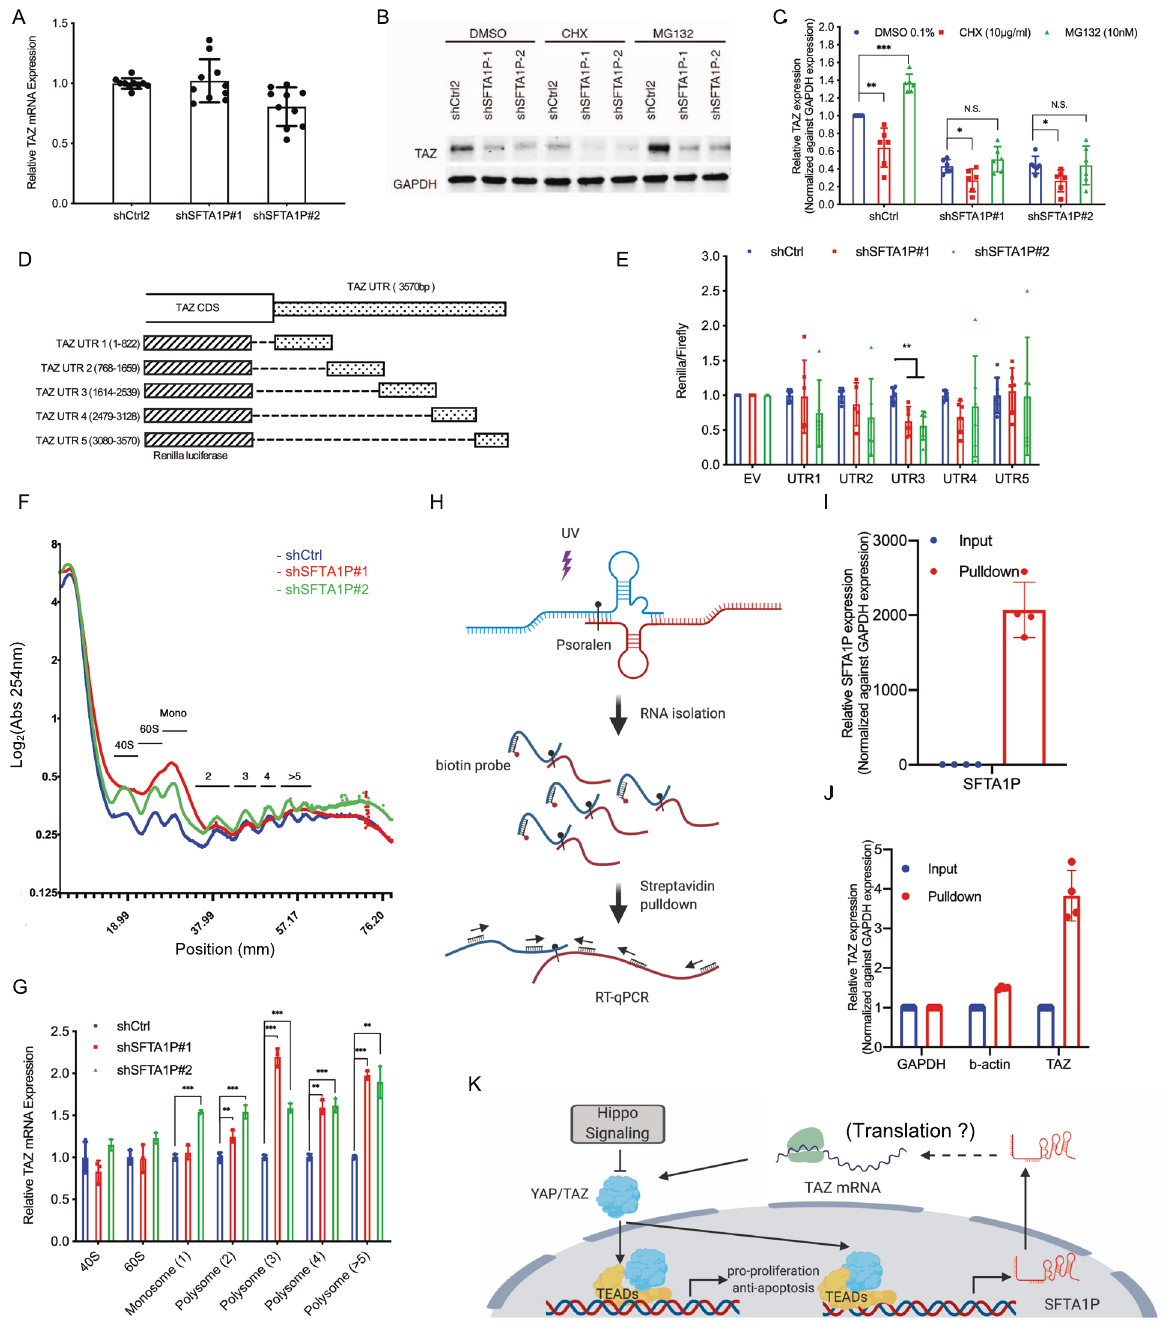
Fig. 4 The 3 ′ -UTR of TAZ mRNA is responsible for SFTA1P-mediated regulation. A RT-qPCR analysis of the TAZ mRNA upon shRNA treatments in the H1299 cells. Mean ± SD, n = 10 (biological replicates). B – C Western blot ( B ) and quantitative analysis ( C ) of TAZ protein expression in the H1299 cells stably transduced with shCtrl or shSFTA1Ps followed by the treatment of 1% DMSO, 10 µg/ml cycloheximide (CHX), and 10 µM MG-132 for 6 h. YAP, TAZ, and GAPDH were examined. Mean ± SD, n = 6 (biological replicates). D A schematic illustration of the 3 ′ -UTR region of TAZ and the fragments subcloned into a psicheck2 reporter plasmid. E Dual-luciferase assay was conducted by transiently transfecting psicheck2 reporters into the shRNA-transduced. The readouts of renilla luciferase were normalized against the corresponding readouts of fi re fl y luciferase. Mean ± SD, n = 6 (biological replicates). F – G Polysomal pro fi ling followed by RT-qPCR. The cytosolic extracts obtained from shRNA-transduced cells were subjected to sucrose gradient centrifugation. The concentrations of ribosomes in each fraction are continuously estimated by UV absorbance (A254) ( F ). The TAZ mRNA associated with ribosomal subunits (40S and 60S), monosomes (80S), and polysomes are isolated and subjected to RT-qPCR analysis ( G ). Mean ± SD, n = 3 (technical replicates). The results was consistent in two independent experiments. H A schematic presentation of work fl ow. Brie fl y, double-stranded RNAs were crosslinked using Psoralen-UV method. A set of biotin-oligos against SFTA1P transcript was employed to enrich SFTA1P and the RNAs associated with it. The enriched RNA was then quanti fi ed using RT-qPCR. I – J RT-qPCR analysis of SFTA1P ( I ), GAPDH ( J ), b-actin ( J ), and TAZ ( J ) in the RNAs enriched by biotin-oligos against SFTA1P. Mean ± SD, n = 4 (biological replicates). K A proposed mechanism where SFTA1P, a YAP/TAZ transcriptional target, mediates a positive feedback regulation of the Hippo-YAP/TAZ signaling pathway by regulating TAZ at the level of translation. Statistical analysis was conducted using Student ’ s t -test, * p < 0.05, ** p < 0.01, *** p < 0.001. Cell Death Discovery (2021)